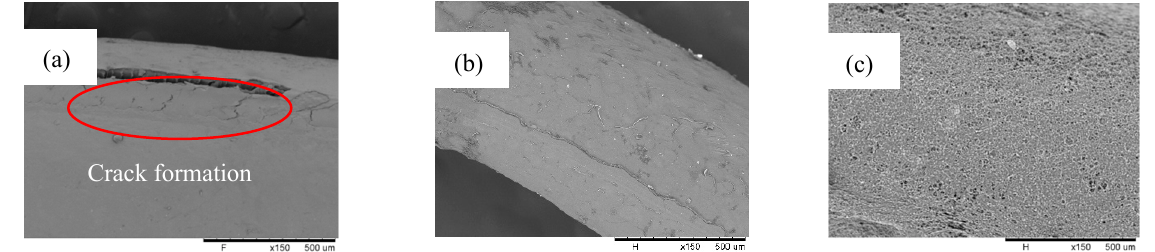
Figure 4. SEM surface morphology images for the modified membranes with the non-solvent at different concentrations: ( a ) 10 mg mL − 1 ; ( b ) 25 mg mL − 1 ; and( c ) 40 mg mL − 1 . A magnification of 150× was used for each concentration.